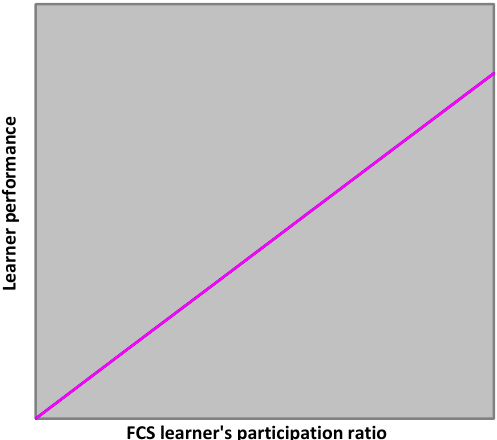
Figure 28. Group quality of collaboration assessment.